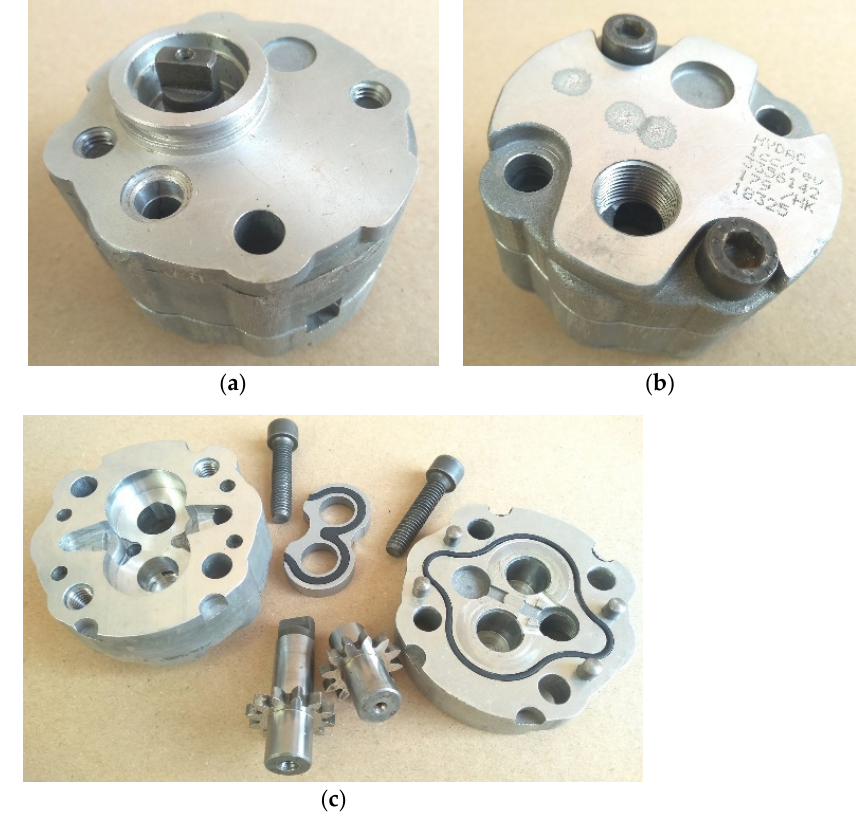
Figure 1. Assembly view of the spur gears pump and its components. Figure 2 features an expanded 3D model to identify each of the pump components.